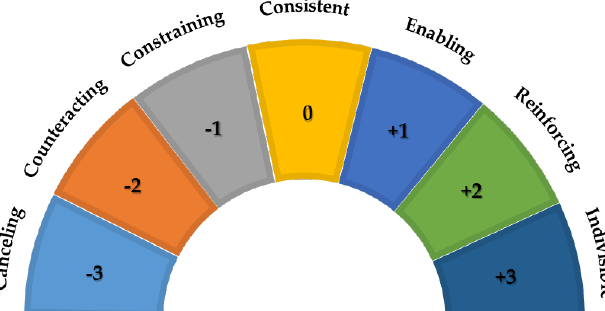
Figure 2. Scoring framework for interactions between the United Nations Sustainable Development Goals (SDGs) and targets [26].